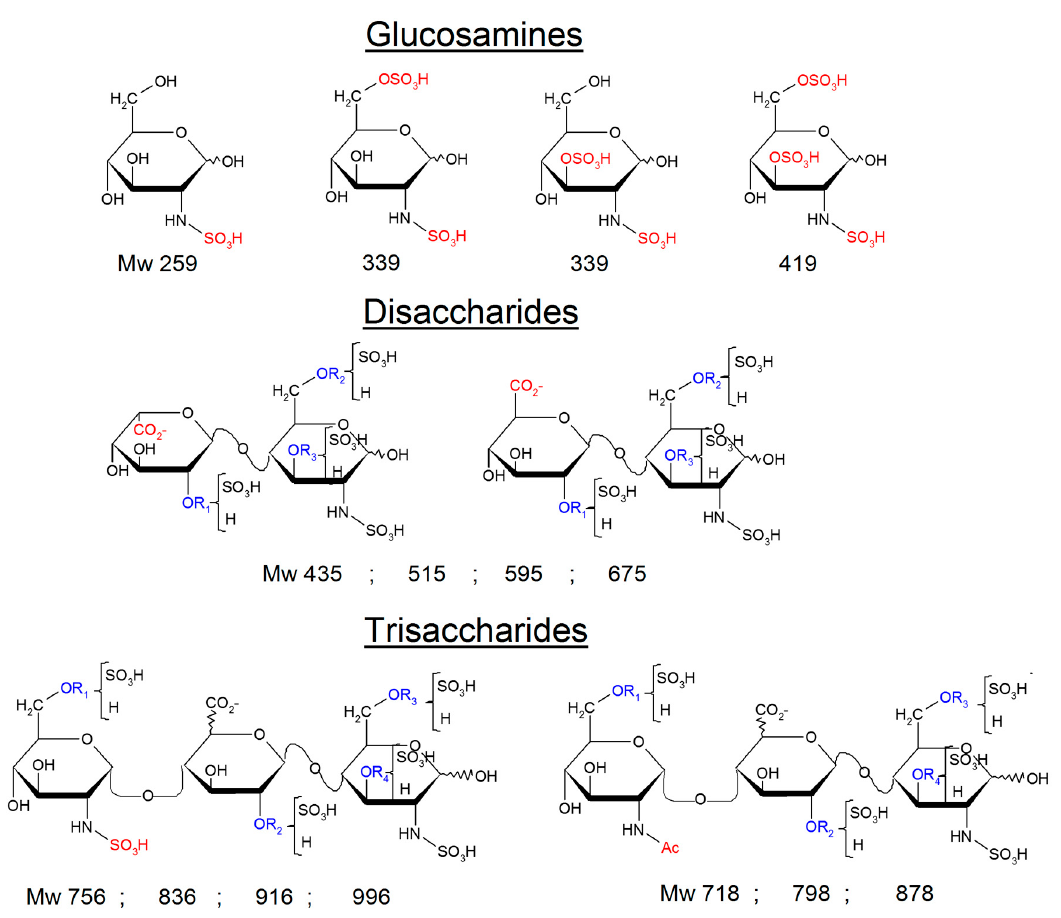
Figure 5. Building blocks corresponding to nonreducing-end (NRE) detected in liquid chromatography-mass spectrometry (LC / MS) of heparin